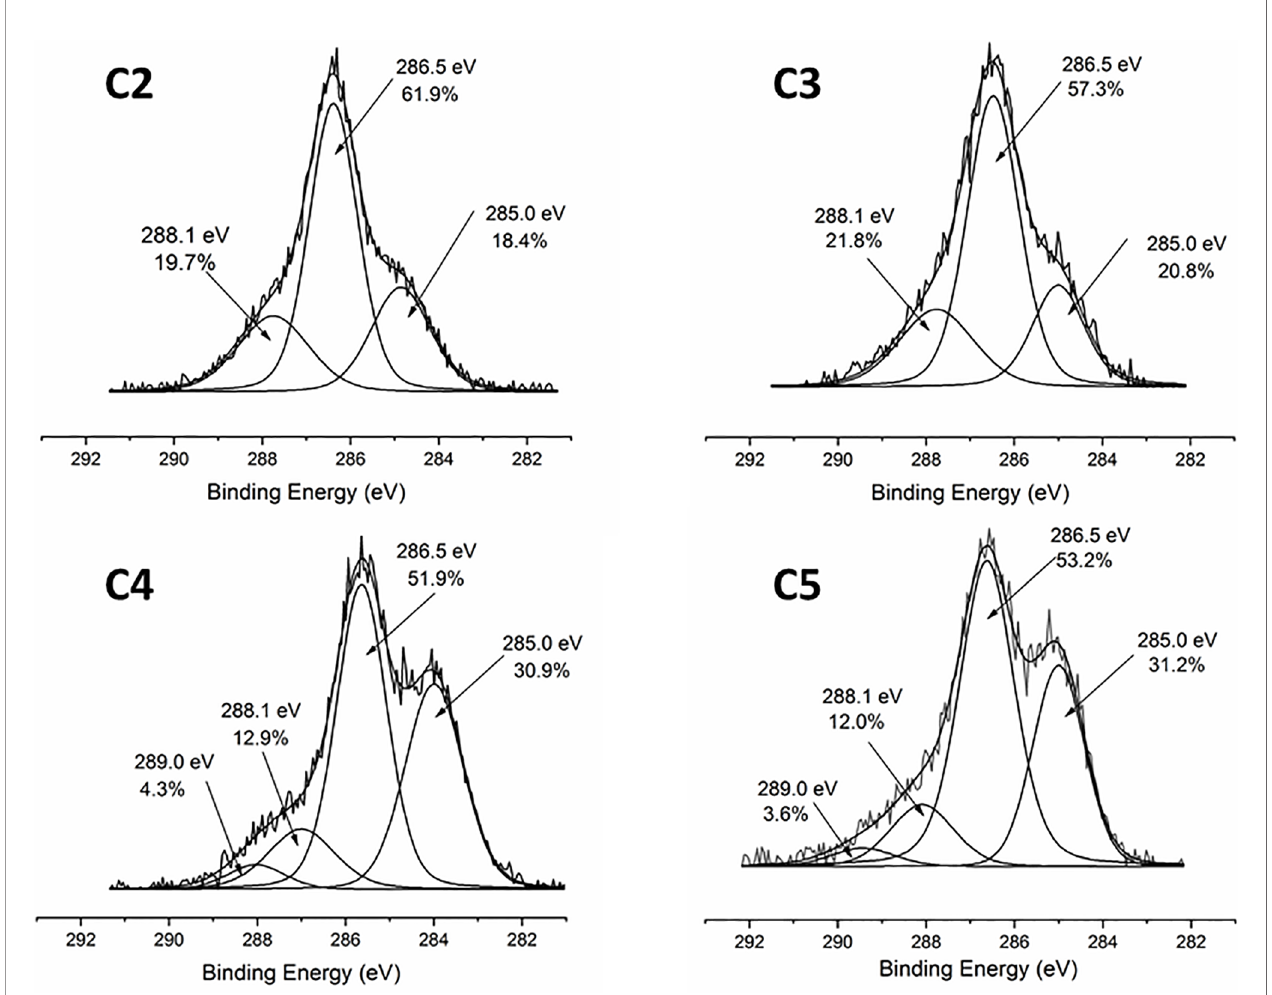
FIGURE 1 | XPS high resolution C1s spectra of agarose-based coating on Ti6Al4V surfaces: C2-Agr; C3-Agr/GS; C4-Agr/TA/GS, and C5-Agr/TA/GS/CaCl 2